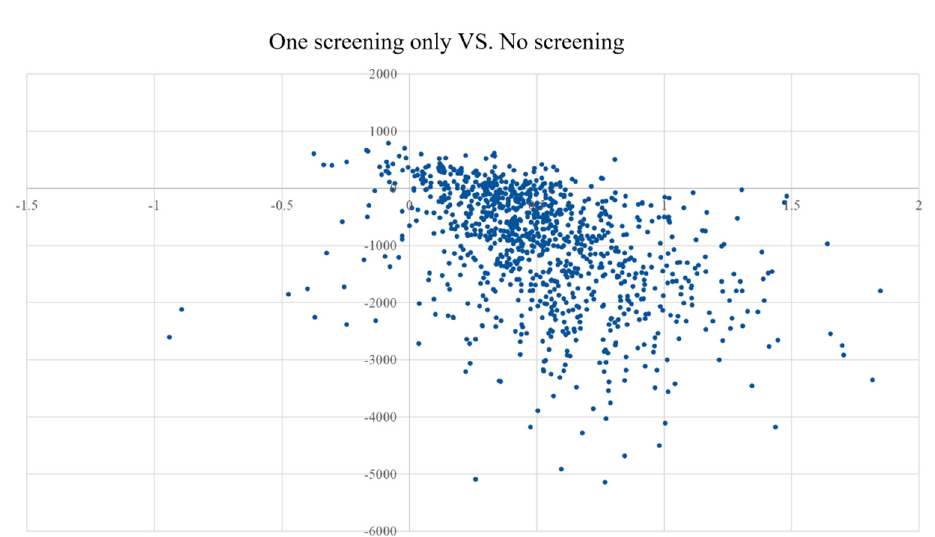
Figure 5. CE plane showing the incremental costs and incremental QALYs of 1000 simulations for One screening only group vs. No screening group.